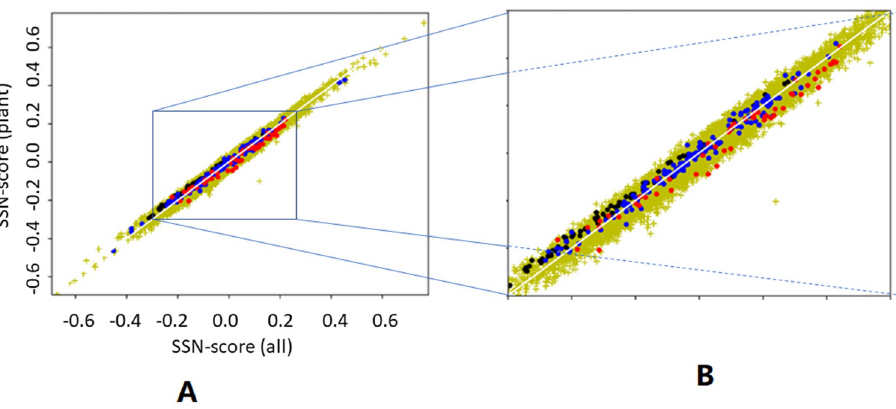
Figure 7. SSN scores based on plant-based versus general preference parameters. SSN scores for all 22,405 proteins were determined twice. For the abscissa, the SSN scores were determined using preference parameters extracted from all proteins, while for the ordinate, the SSN scores were determined using preference parameters obtained from 156 plant proteins. So, dots above the (white) Plant-SSN=All-SSN diagonal line represent proteins that have a higher SSN score when the preference parameters are determined from plant proteins only, while dots below the line get a higher SSN score when general preference parameters are used. Yellow: all proteins; Blue: plant proteins; Black: Haemoglobins; Red: antibodies. ( A ) the whole plot including all 22,405 proteins; ( B ) blown-up part of the left-hand side plot showing most red, blue, and black dots to better see the systematic nature of the asymmetries of these colored dots.